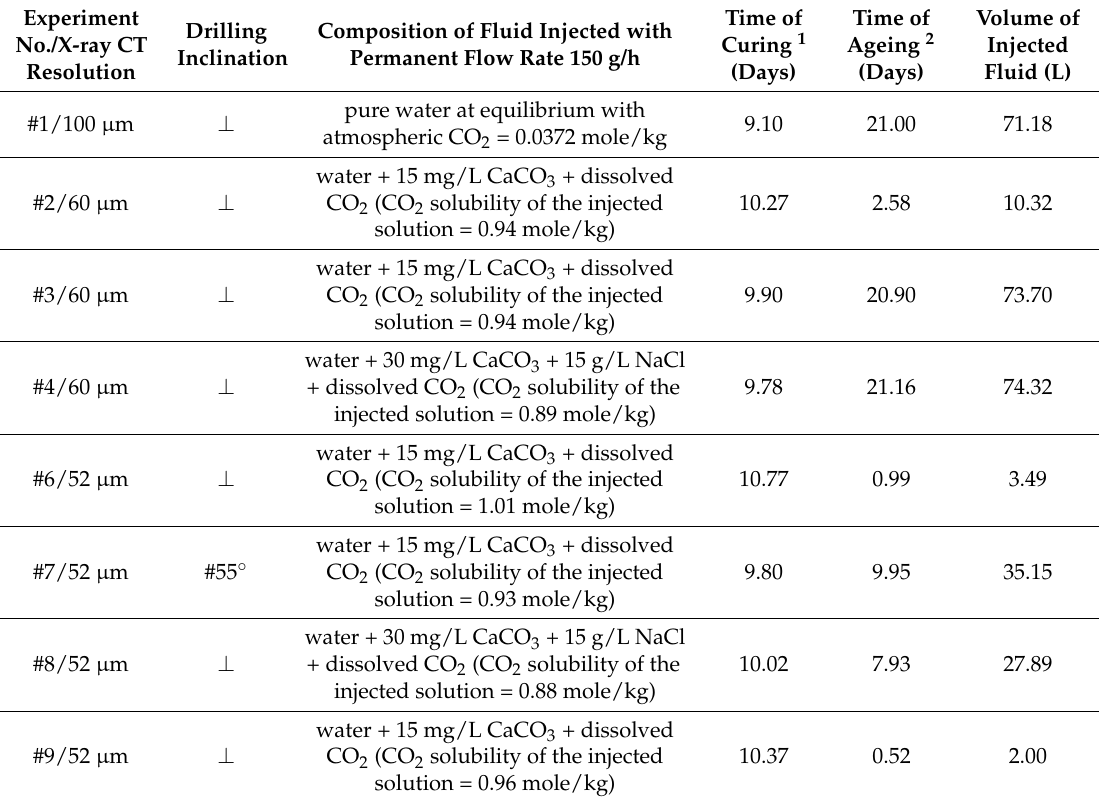
Table 1. Summary of the conditions for the performed